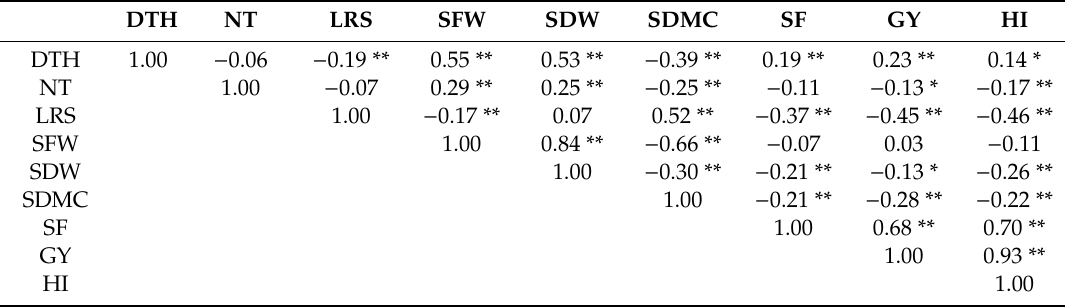
Table 2. Pearson correlation coe ffi cients among various agronomic traits, yield, and yield-related traits in rice genotypes under drought